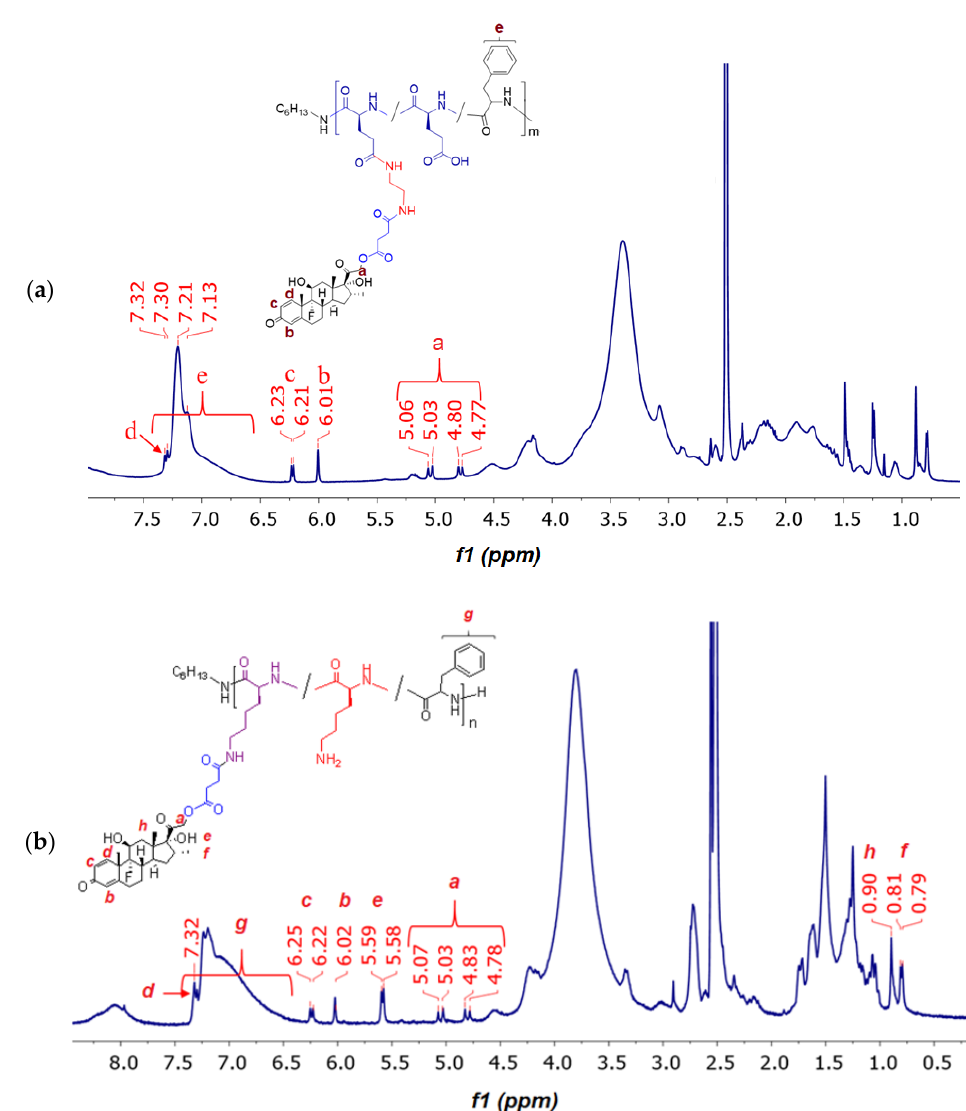
Figure 6. 1 H NMR spectrum of P[EF]-DEX ( a ) and P[KF]-DEX ( b ) conjugates (DMSO-d 6 ).